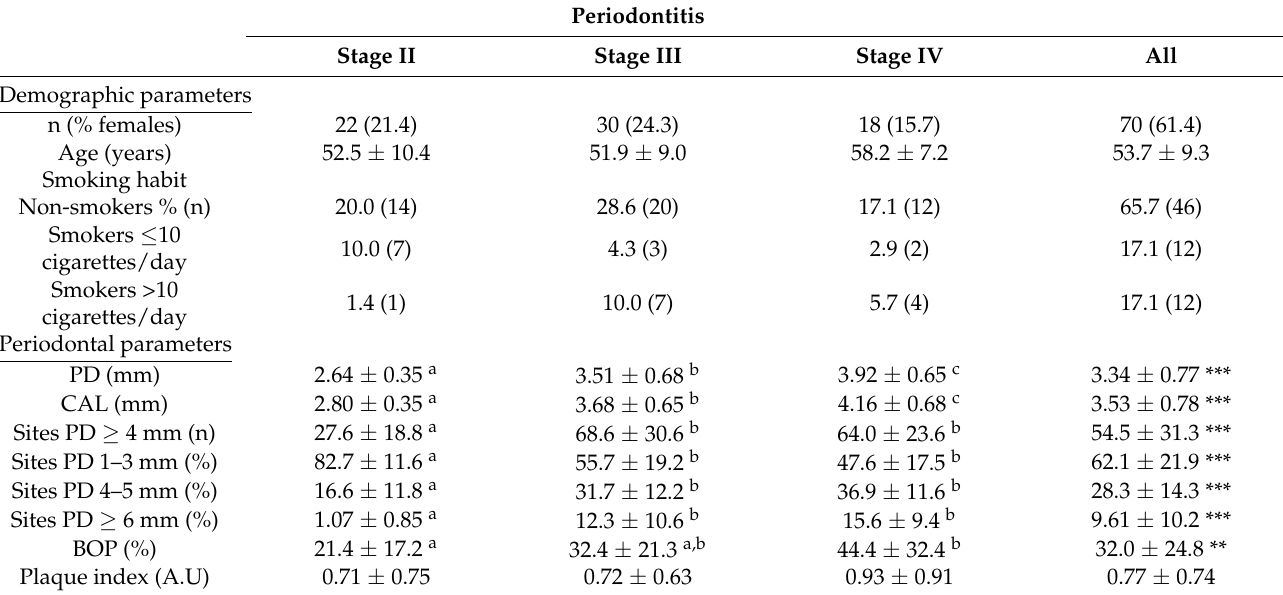
Table 1. Descriptive study population parameters according to periodontitis